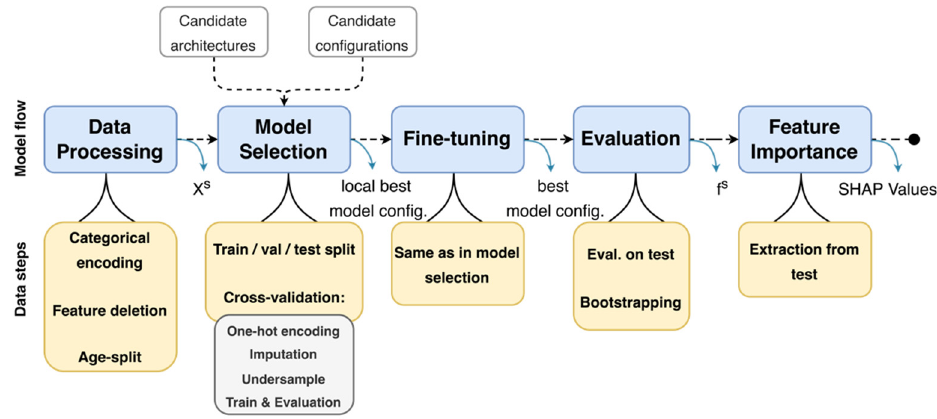
Figure 1. Modelling and data pipeline: a classifier f s and its quality metrics is obtained for each dataset X s .